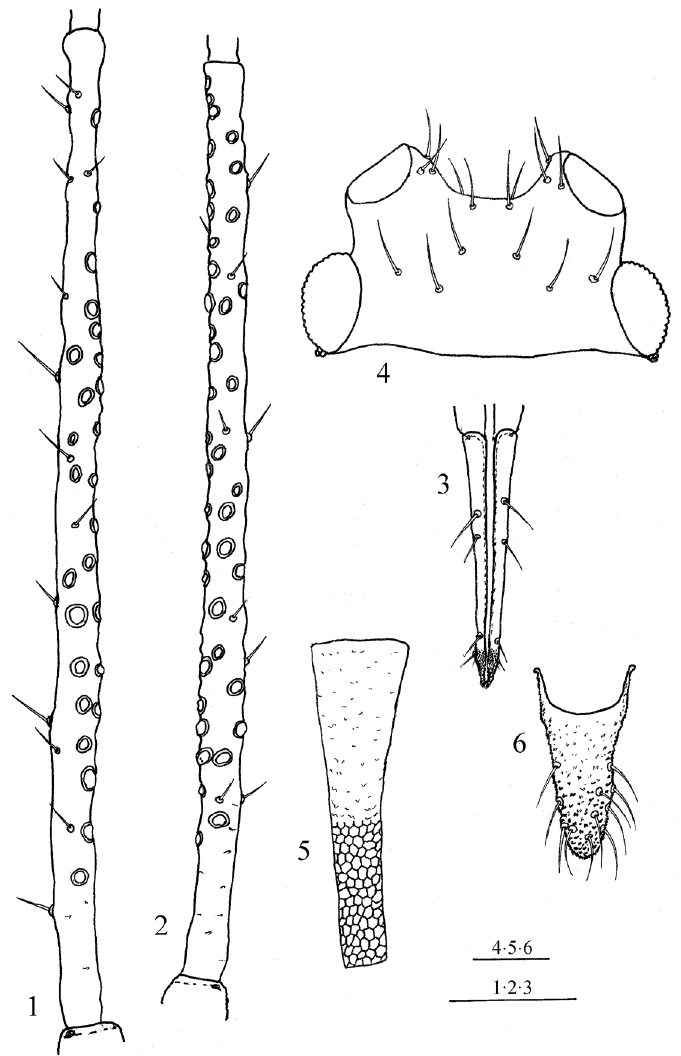
Figure 3. Macrosiphoniella remaudierei sp. n. 1 third antennal joint of apterous viviparous 2 same of alate viviparous 3 shape of ultimate rostral joint of apterous viviparous 4 head of apt. viv. 5 siphunculus of apt. viv. female 6 cauda of apt. viv. female. Scale bars 0.1